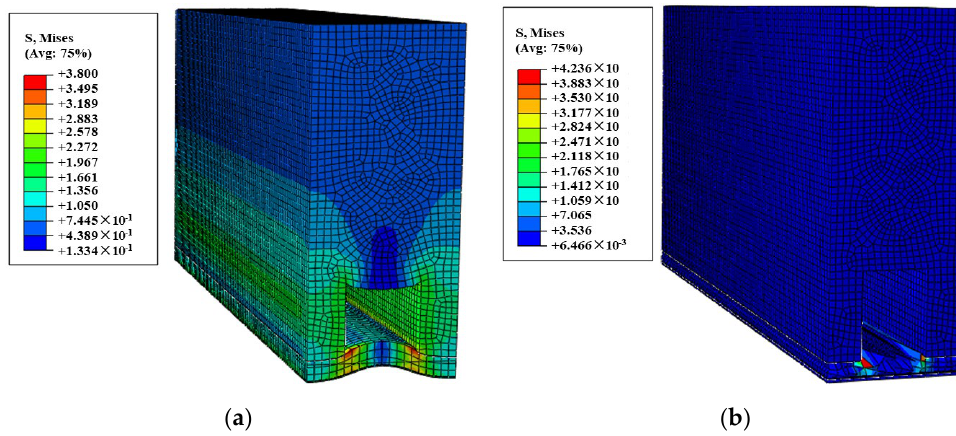
Figure 7. Stress distribution of a simplified PEMFC unit cell by a linear and isotropic model of a GDL in ( a ) and a 3-D nonlinear and orthotropic constitutive model in ( b ).